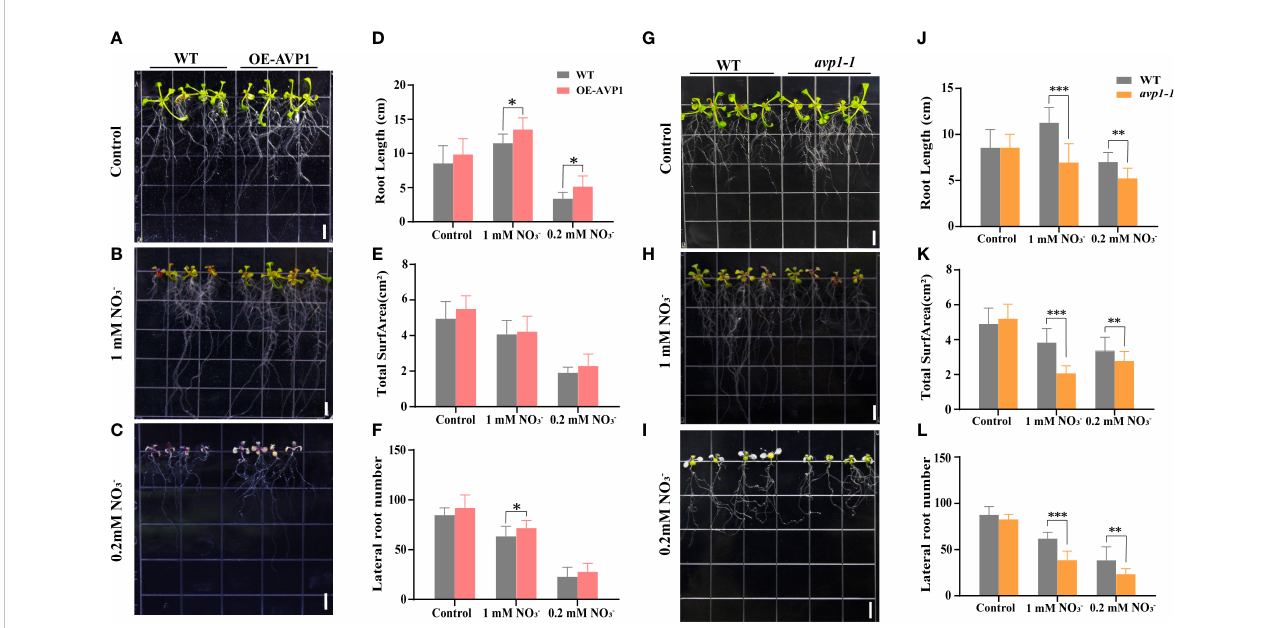
FIGURE 1 Functions of AtAVP1 in Arabidopsis under normal conditions and different levels of nitrogen stress Phenotypic analysis of the transgenic AtAVP1 Arabidopsis line OE-AVP1 grown under (A) 6 mM NO − 3 (control), (B) 1 mM NO − 3 , and (C) 0.2 mM NO − 3 (low nitrogen) conditions. Images were taken after 5 d of growth on different media. DIAN Win RHIZO Pro 2012 root scanning software and EPSON Flatbed and Expression 10000XL scanners were used to scan and measure the roots. (D) Root length, (E) total root surface, and (F) lateral root number of OE-AVP1 lines grown under different nitrogen treatment conditions. Phenotypic analysis of the mutant avp1-1 under (G) 6 mM NO − 3 (control), (H) 1 mM NO − 3 , and (I) 0.2 mM NO − 3 medium conditions. Images were taken after 7 d of growth; the (J) root length, (K) total root surface, and (L) lateral root number of avp1-1 lines grown under different nitrogen treatments were measured. All data represent mean ± standard deviation (n ≥ 6). (* p< 0.05, ** p < 0.01, *** p < 0.001, Duncan ’ s multiple range test). Scale bars = 0.5